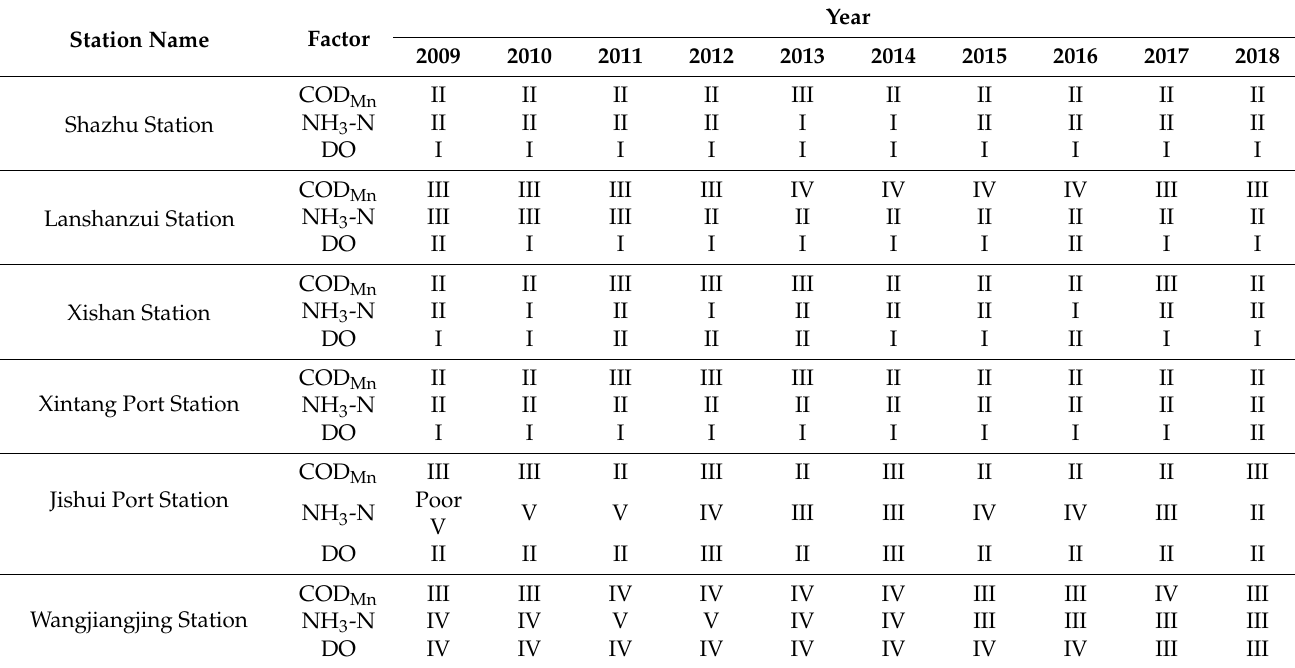
Table A1. Water quality evaluation results of each water quality factor based on one-factor evaluation.